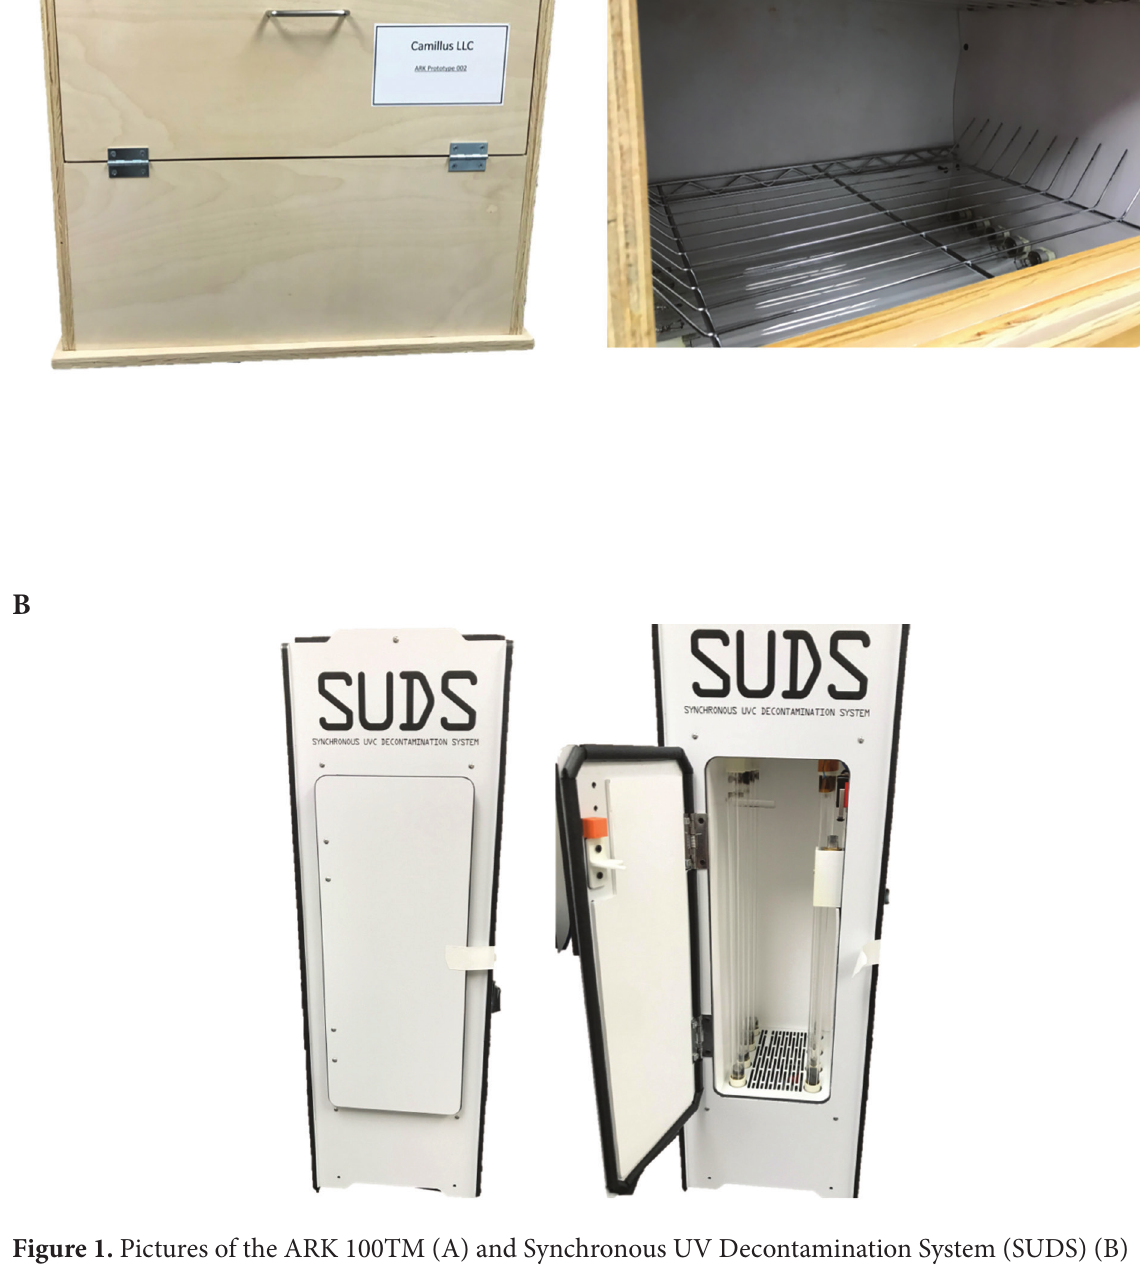
Figure 1. Pictures of the ARK 100TM (A) and Synchronous UV Decontamination System (SUDS) (B)